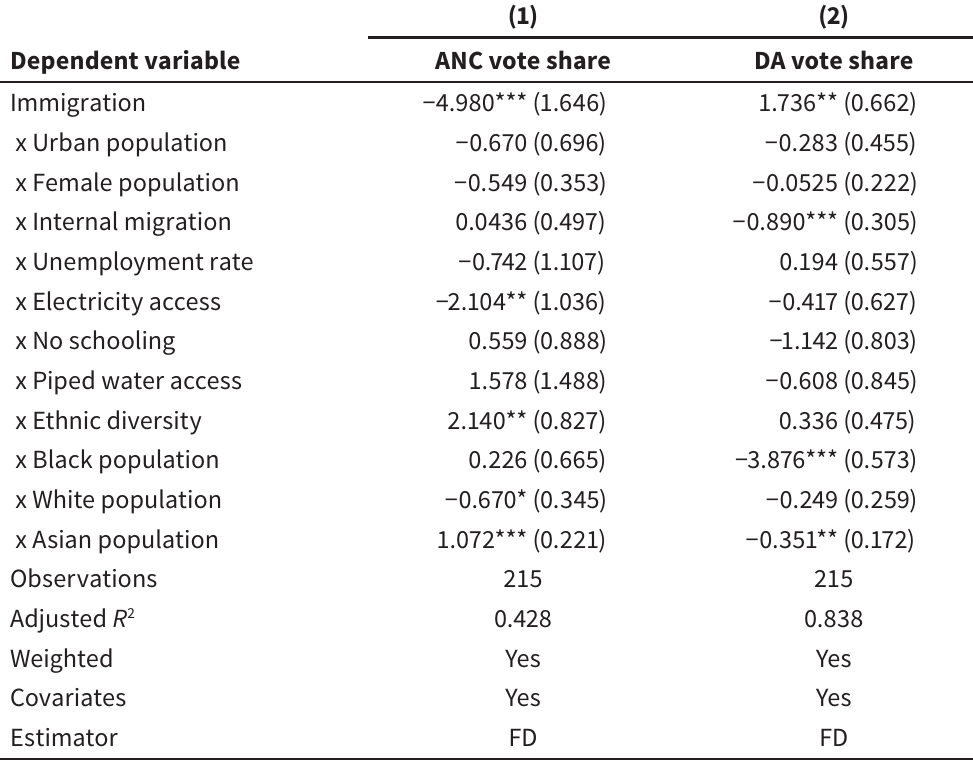
Heterogeneity analysis